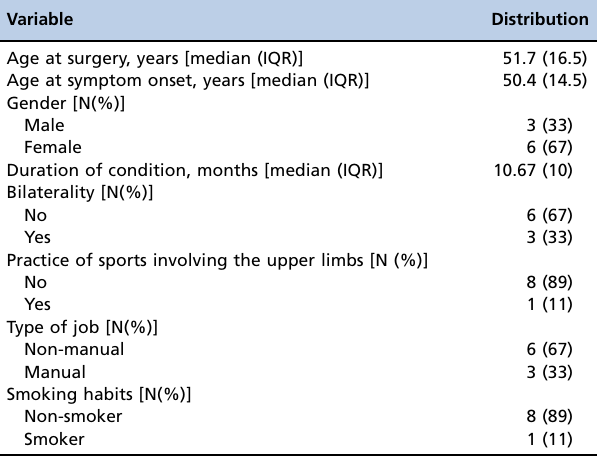
Table 1 - Distribution of clinical variables for patients with adhesive